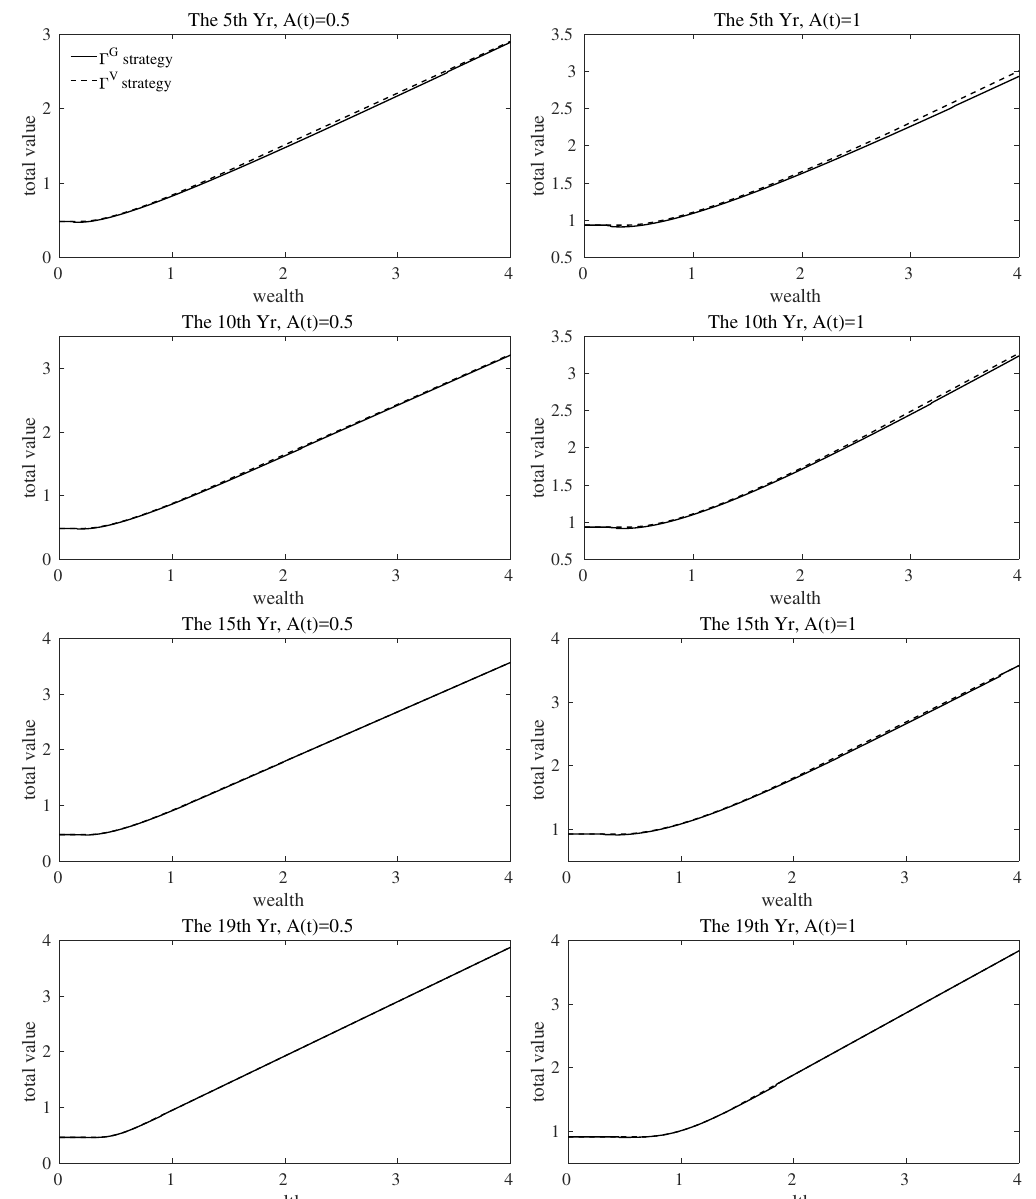
Figure 1. Total value as a function of wealth, respectively under the two strategies for guarantee account levels 0.5 and 1 at the end of 5th, 10th, 15th and 19th years of a contract with a maturity of 20 years. The market conditions are r = 1% and σ =